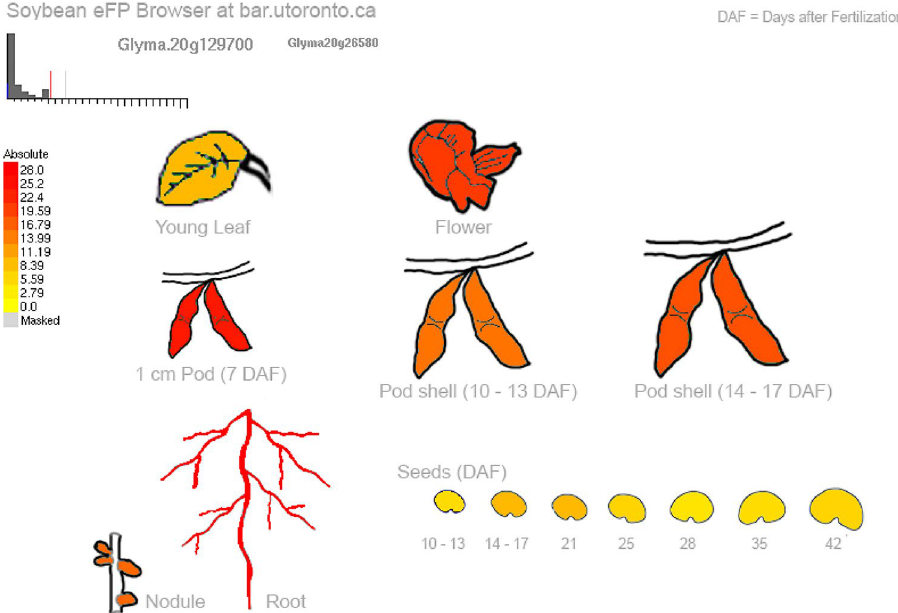
Figure 7. Expression profile of Glyma.20g129700 based on previous transcriptomic analysis in soybeans. Expression strength coded by color: yellow = low, red = high. As shown, Glyma.20g129700 is most highly expressed in flowers, pods, roots, pod shells and in the seed. Data derived from RNA-seq of Glycine max , published by Severin et al. 21 and download from eFP browser 29 (www.bar.utoro